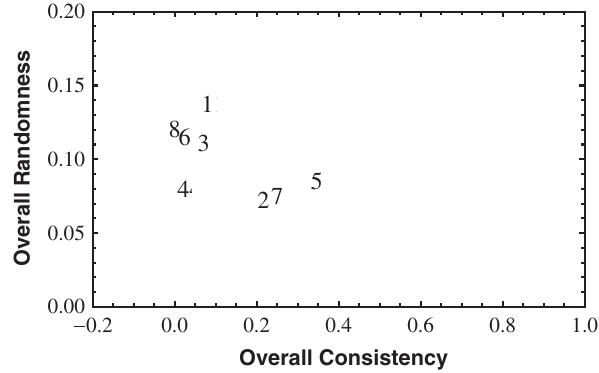
FIG. 13. Overall randomness versus overall consistency for eight statements of the form ‘‘[both trajectories] will have equal times of flight’’ that correspond to the eight projectile pairs shown in Fig. 11. This statement should be answered ‘‘false’’ in each case.